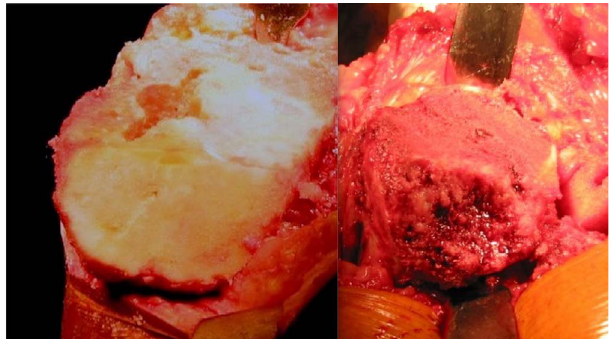
Figure 2. Bone loss from posteromedial tibial condyle after tibial cut.